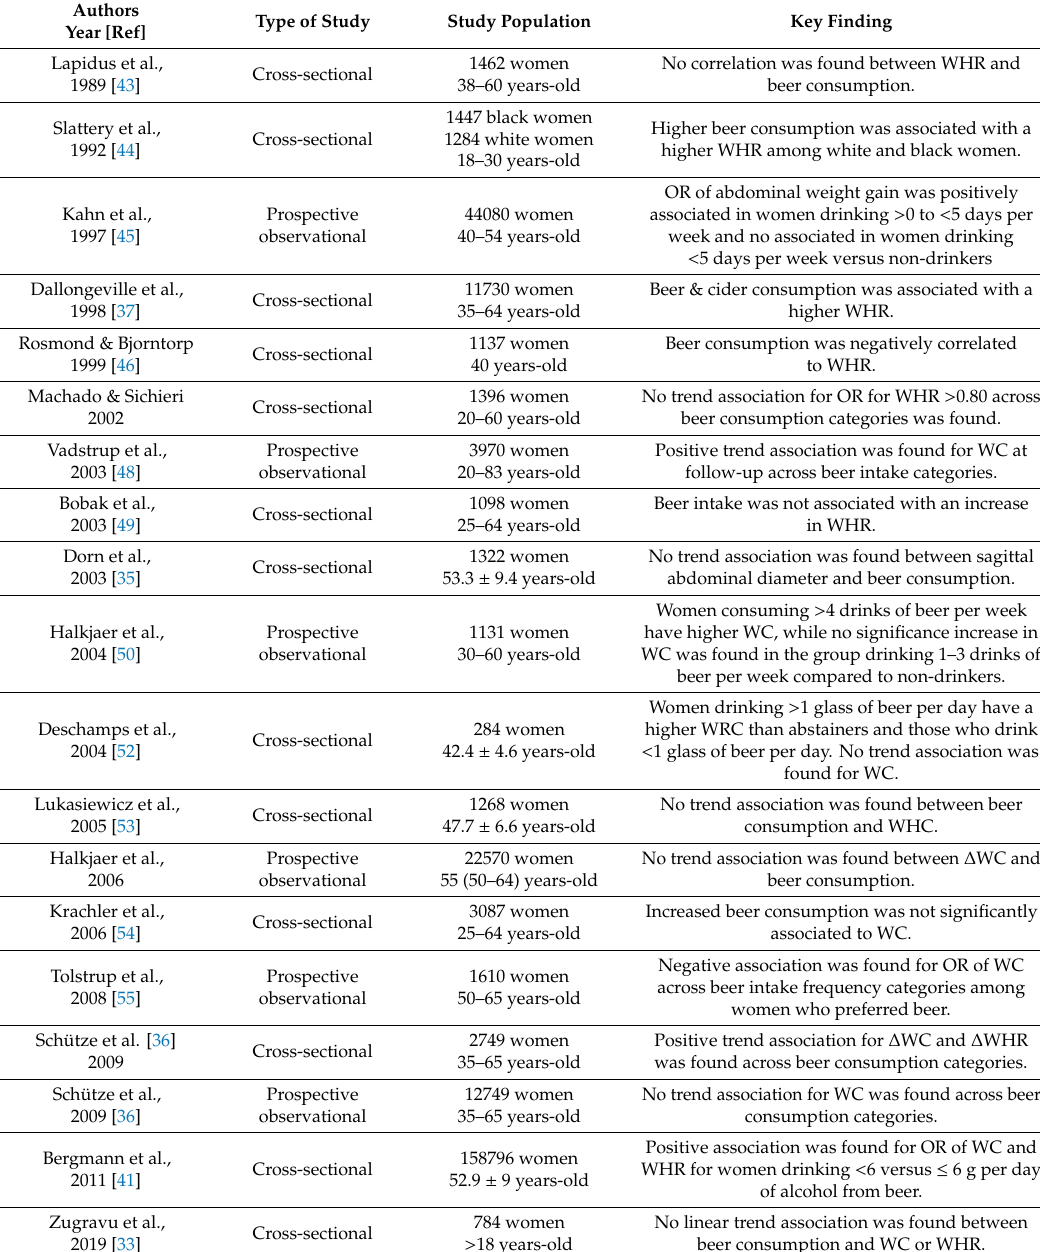
Table 2. Women studies evaluating the relationship between beer consumption and abdominal fat